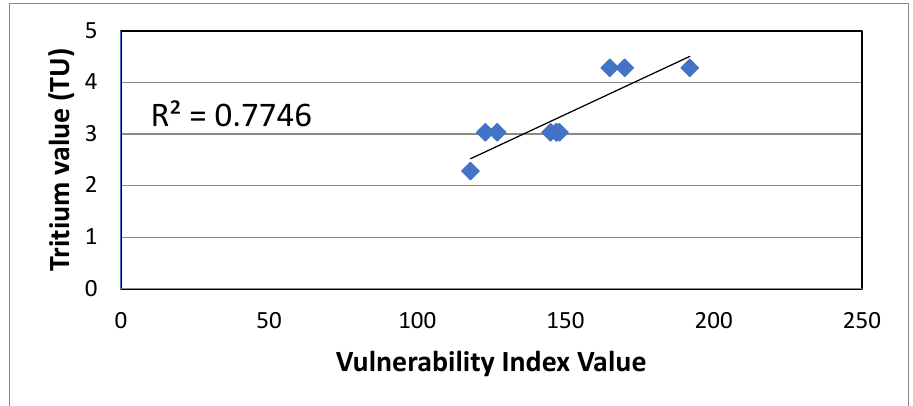
Figure 5. Groundwater age and Tritium value of aquifers at the HSB.